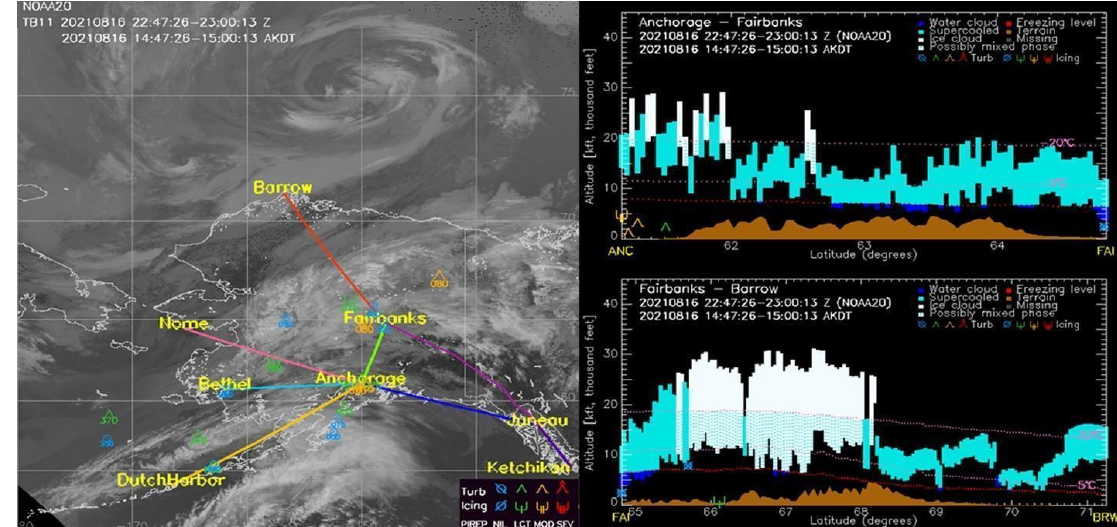
Figure 14. NOAA-20 VIIRS Infrared imagery ( left ) and cloud cross-sections along two flight paths between Anchorage and Fairbanks, and Fairbanks and Utqiagvik-Barrow, Alaska ( right ) used in the NTSB accident investigation which occurred around 2251 UTC on 16 August 2021 near Fairbanks.